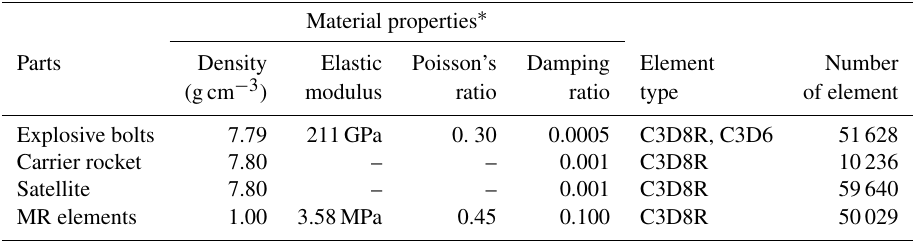
Table 1. Properties and convergent meshes.